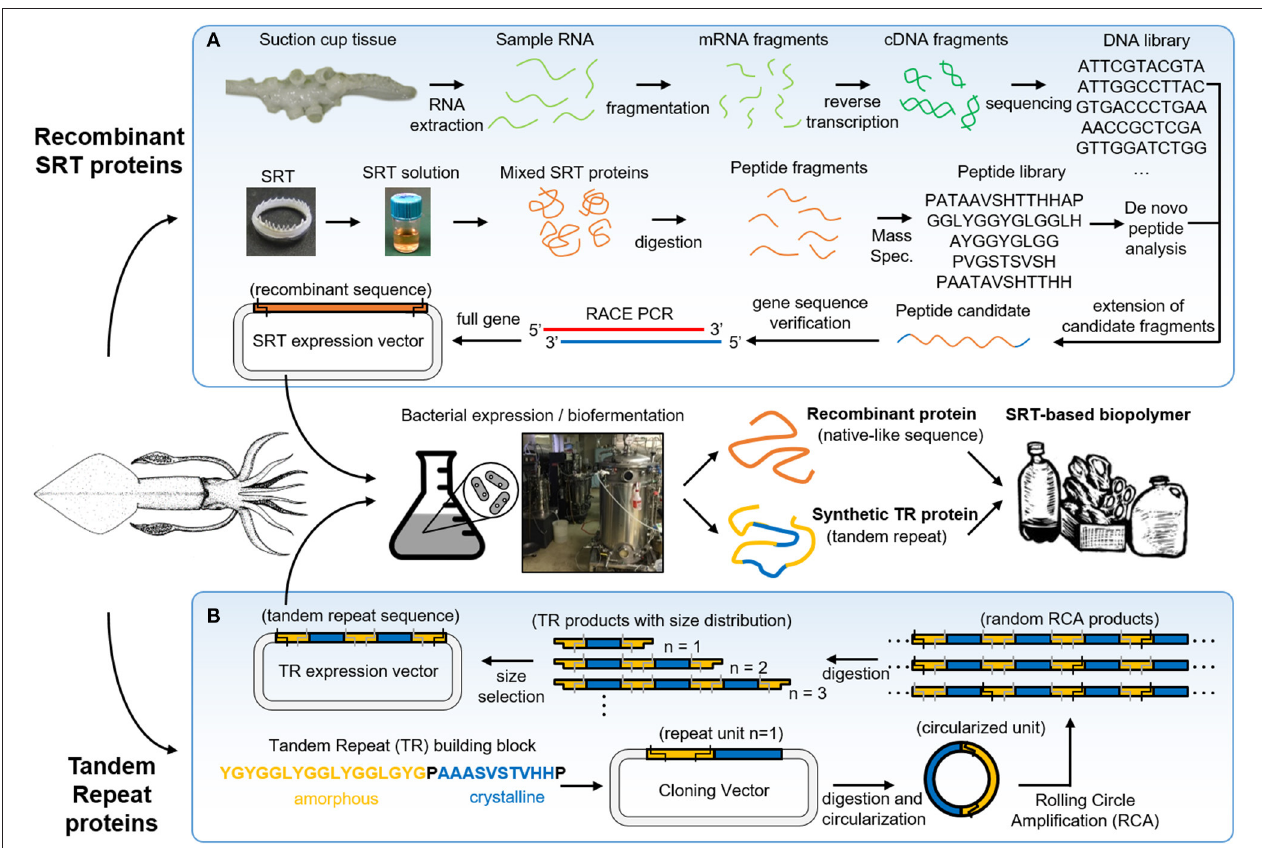
FIGURE 2 | Squid ring teeth (SRT) are found inside suction cups of squid species, which are composed of a protein complex. Proteins can be extracted directly from natural sources, or expressed (A) recombinant and (B) de novo via biosynthetic routes (genetically modified bacteria, yeast). Adapted with